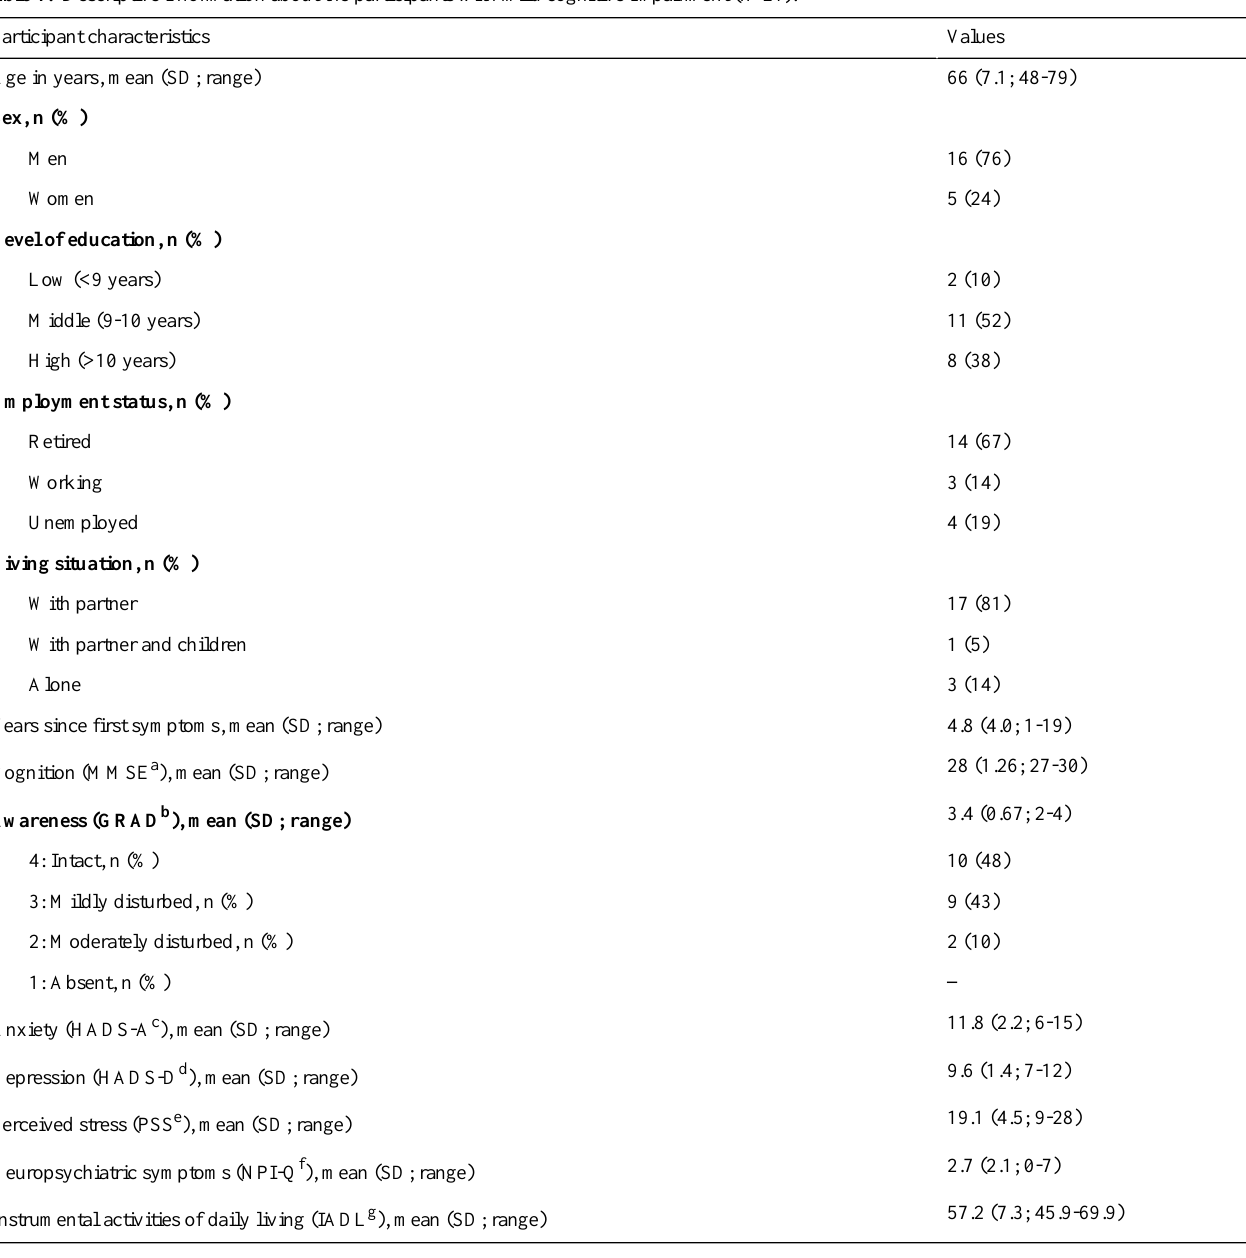
Table 1. Descriptive information about the participants with mild cognitive impairment (n=21). ValuesParticipant